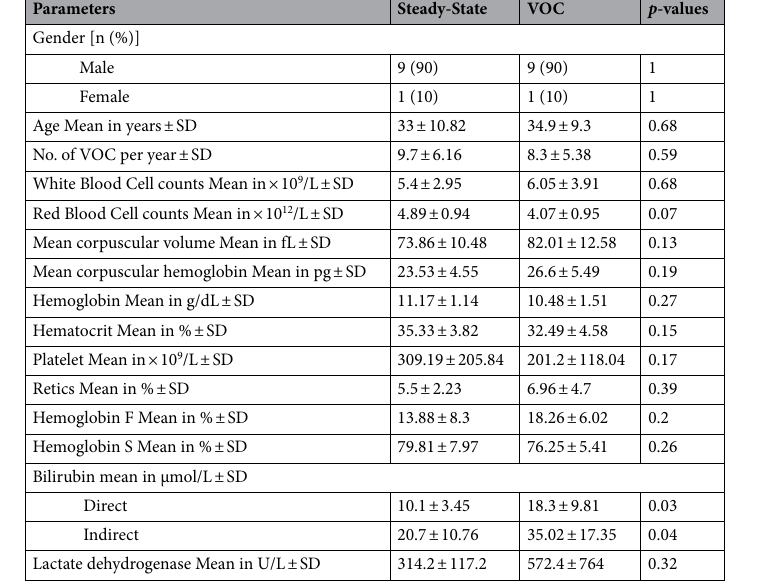
Table 1. Baseline characteristics of the study participants with SCD (n =